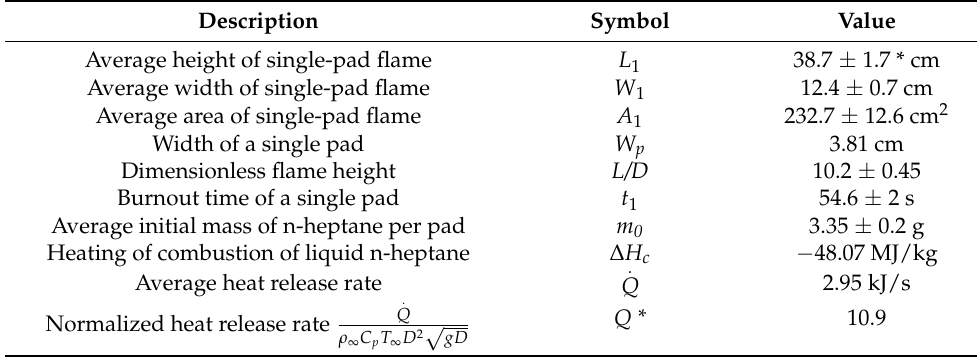
Table 1. Single-pad flame characteristics.